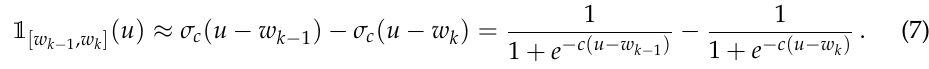
Figure 1. Approximation of the indicator function 1 [ w Factor c controls the steepness and we plot c = 100 (blue), ˆ c = 300 (red) and ¯ c = 500